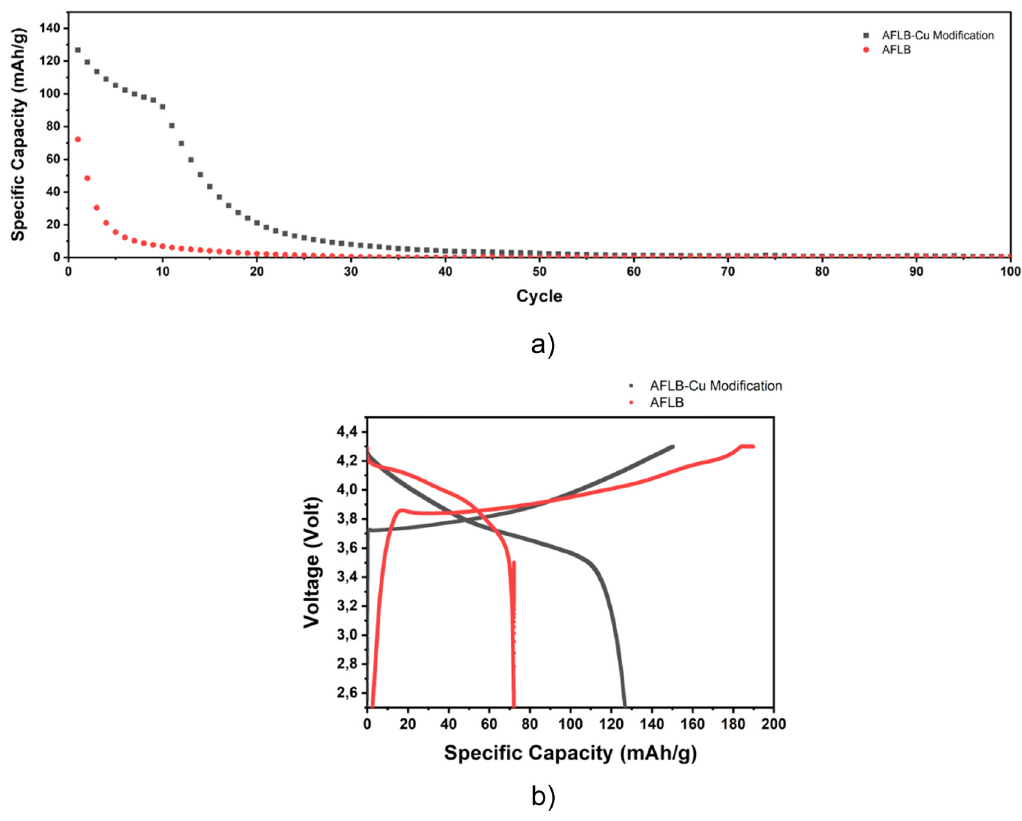
Figure 6: ( a ) Cyclic performance of AFLB with bare and modi fi ed Cu - foil. ( b ) Initial discharge capacity performance of AFLB with bare and modi fi ed Cu -